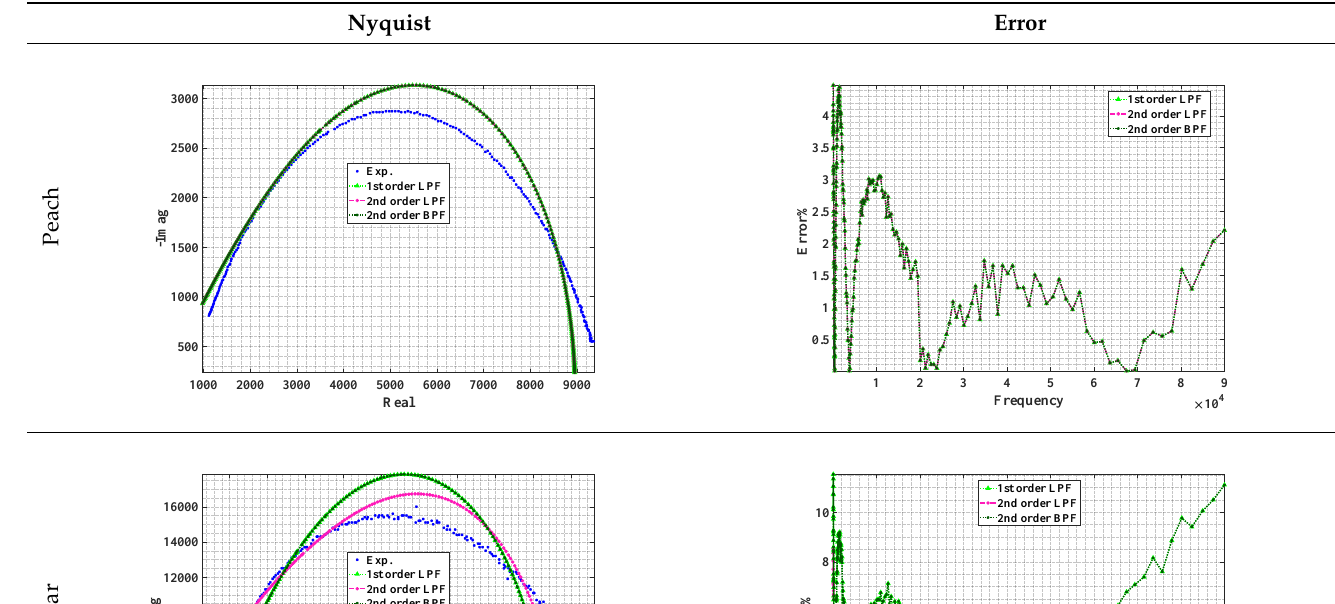
Table 2. Cont . Nyquist